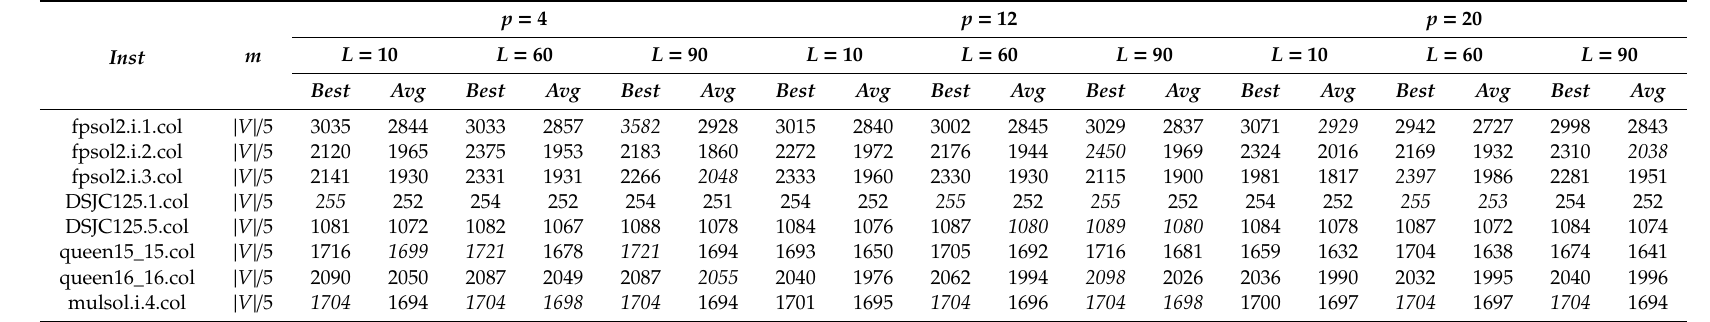
Table 1. Experiments with parameters p and L